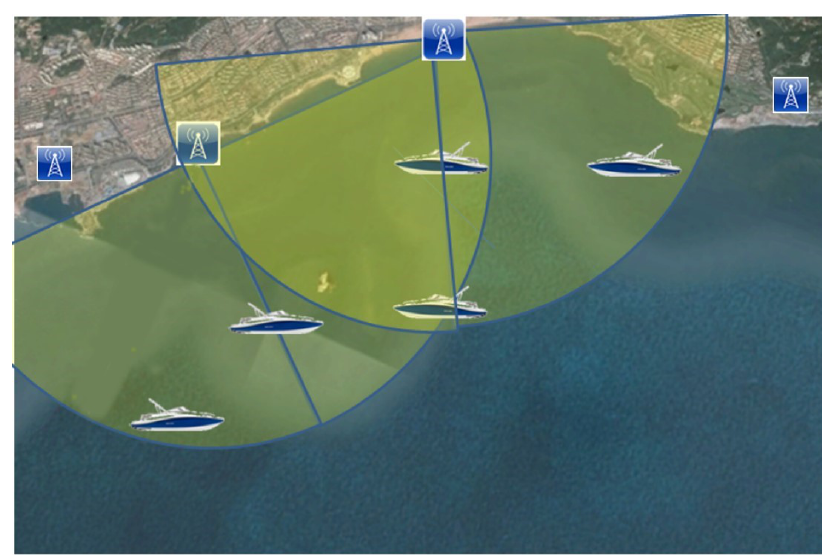
Figure 1. The location model in cellular networks.